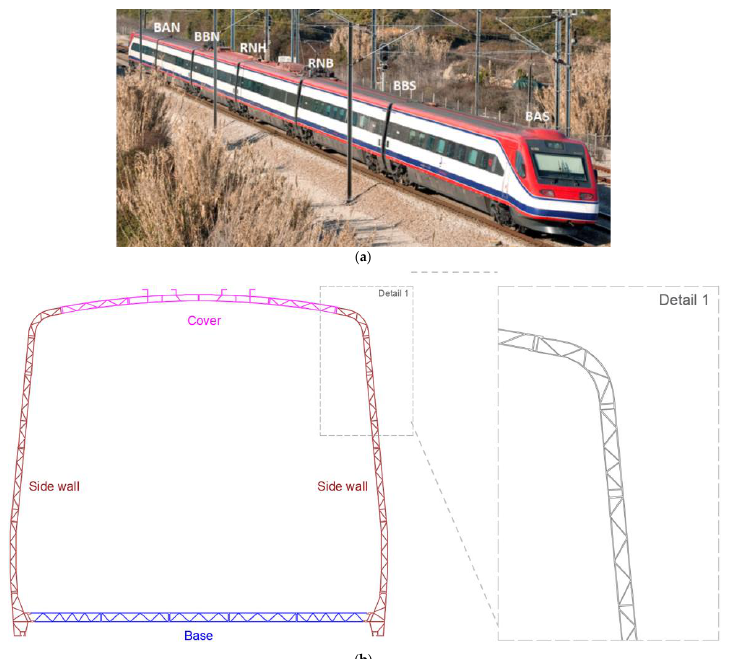
Figure 7. Alfa pendular train: ( a ) perspective view; ( b ) cross-section of the carbody and structural detail.